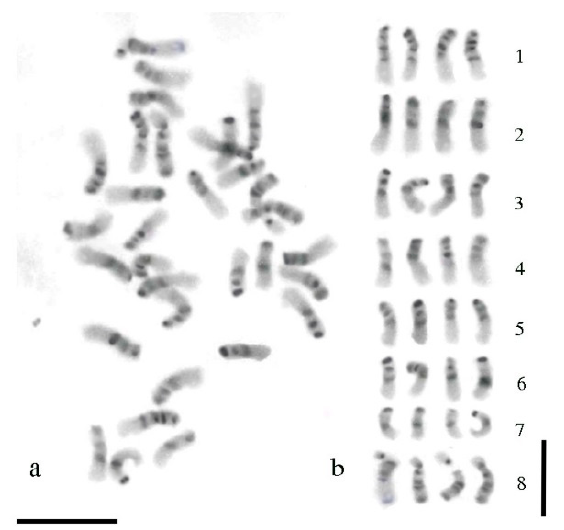
Figure 2. C-banding in the tetraploid alfalfa. ( a ) Mitotic metaphase chromosomes after the C-banding treatment and Giemsa staining; ( b ) karyogram according to Figure 1a; chromosomes were arranged according to their morphological traits and distribution of the heterochromatic bands. The bar represents 5 µm.